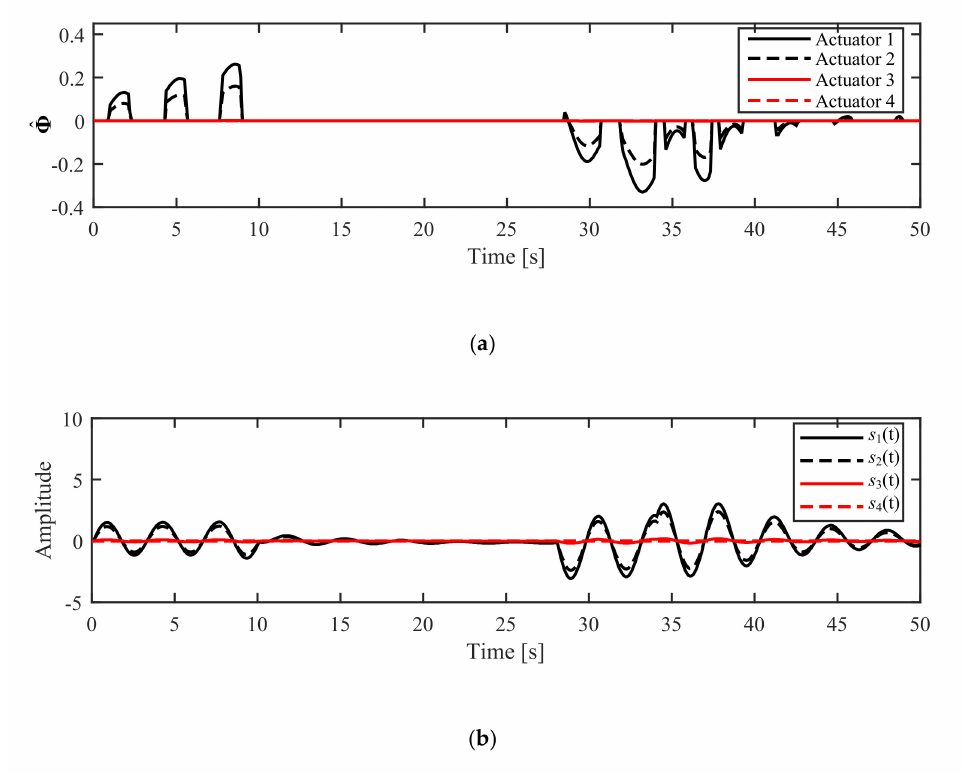
Figure 15. The performance of the proposed controller in AM mode: ( a ) The updating switching gains of ASTSMC-TDE (ASMC term); ( b ) Sliding manifold